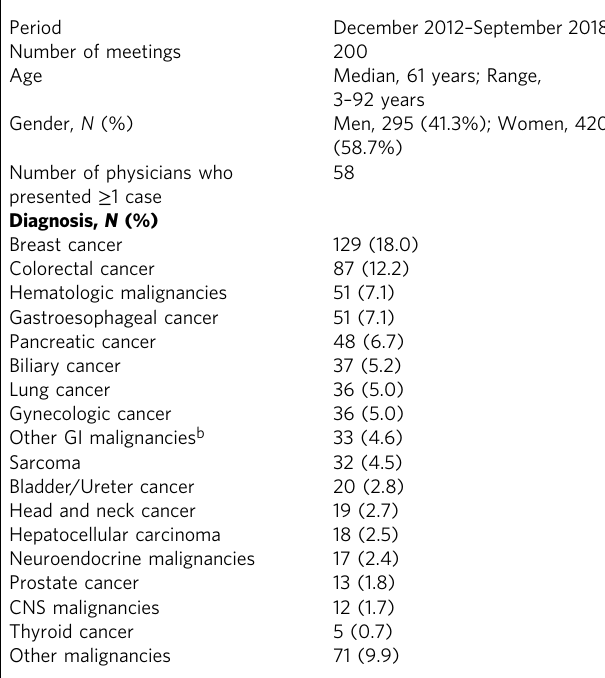
Table 1 Baseline demographics of patients presented at the Molecular Tumor Board ( N = 715 unique patients) a